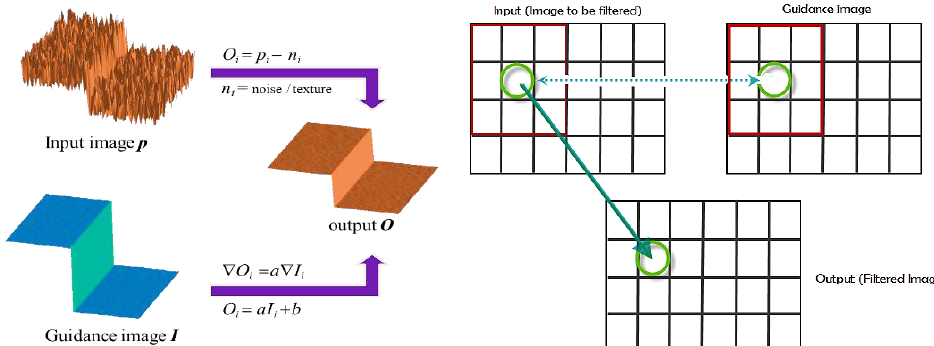
Figure 2. Schematic of the guided filter.